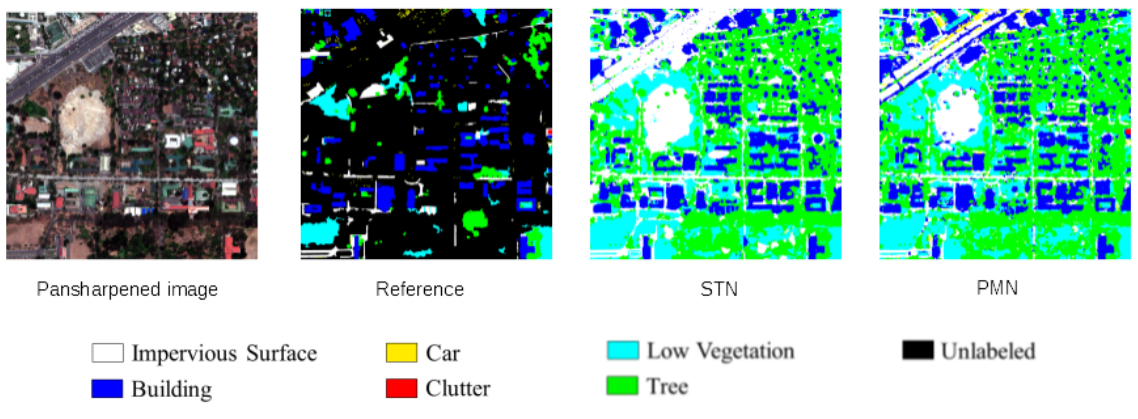
Figure 5. Comparison of predicted land cover maps of Tile 3 using the plain network STN and one of the multitask network